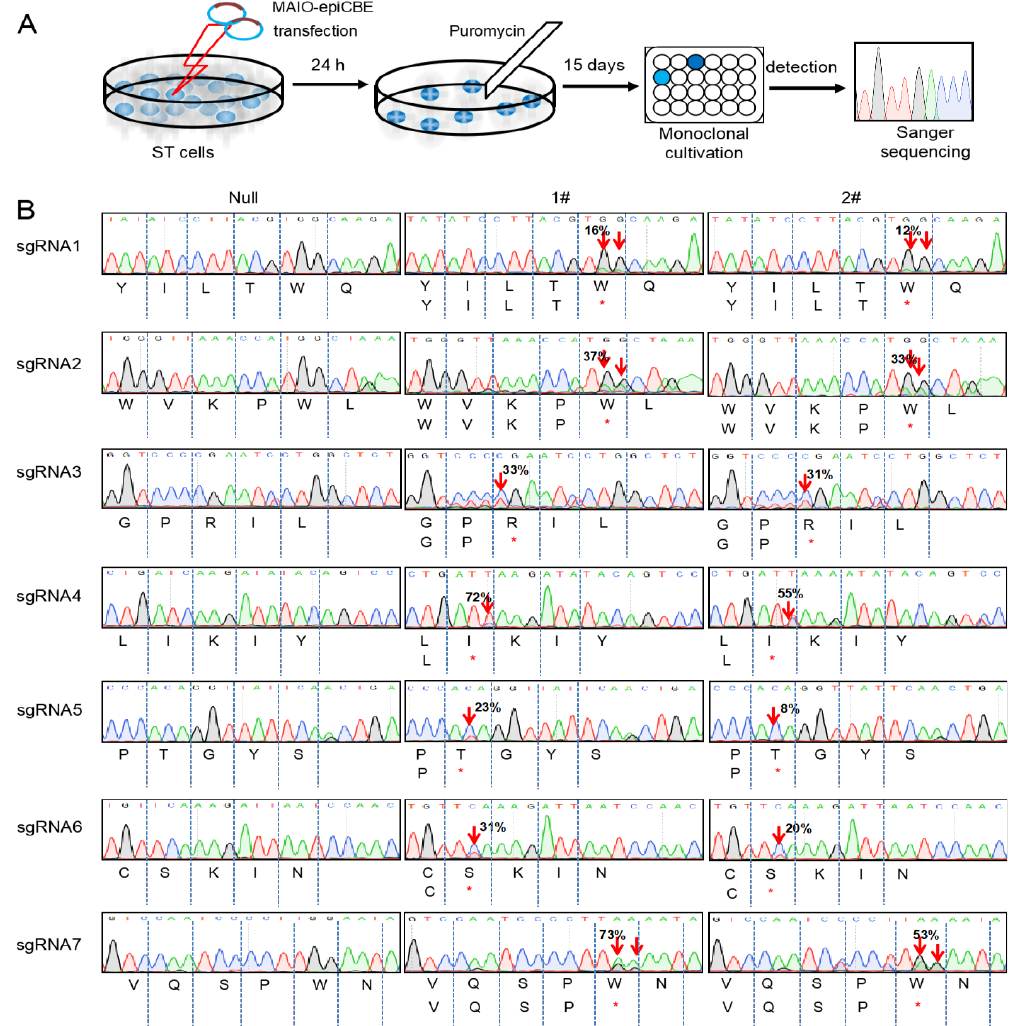
Figure 2. Efficient base editing of PERV genome by MAIO-epiCBE system. ( A ) Schematic of selection for PERV genome-edited clones. ( B ) Base conversion efficiency of clone #1 and #2 detected by Sanger sequencing. All seven target sites were detected and compared to cells transfected with null group. The positions of base substitutions are marked with red arrows. The amino acid sequence and base conversion efficiency are listed under sequence map. * means stop codon site.